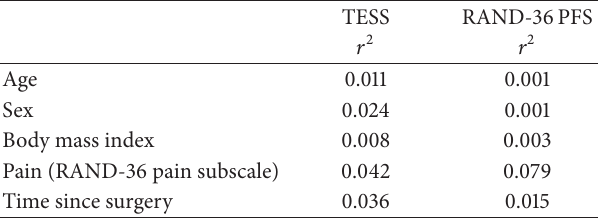
Table 4: Coefficients of determination between patient character- istics and functional outcomes (TESS and RAND-36 physical func- tioning